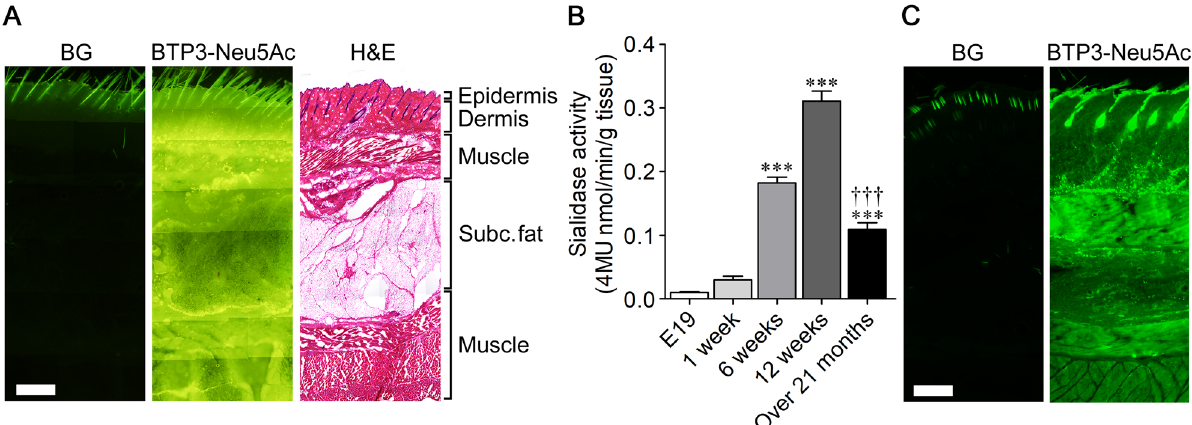
Figure 1. Decreases in sialidase activity in the rat skin with aging. ( A ) Rat tissues of the lateral abdomen were stained with 1 mM BTP3-Neu5Ac (middle column) at pH 7.3 and hematoxylin–eosin (H&E, right column). Background level (BG) for staining with BTP3-Neu5Ac is shown in the left column. Subc.fat: subcutaneous fat. ( B ) Change in sialidase activity in the skin with aging. n = 4–8. *** P < 0.001 vs. E19; ††† P < 0.001 vs. 12 weeks old (one-way ANOVA with Bonferroni’s multiple comparison test). ( C ) Rat tissues of the lateral abdomen were stained with 1 mM BTP3-Neu5Ac at pH4.6. Scale bars, 500